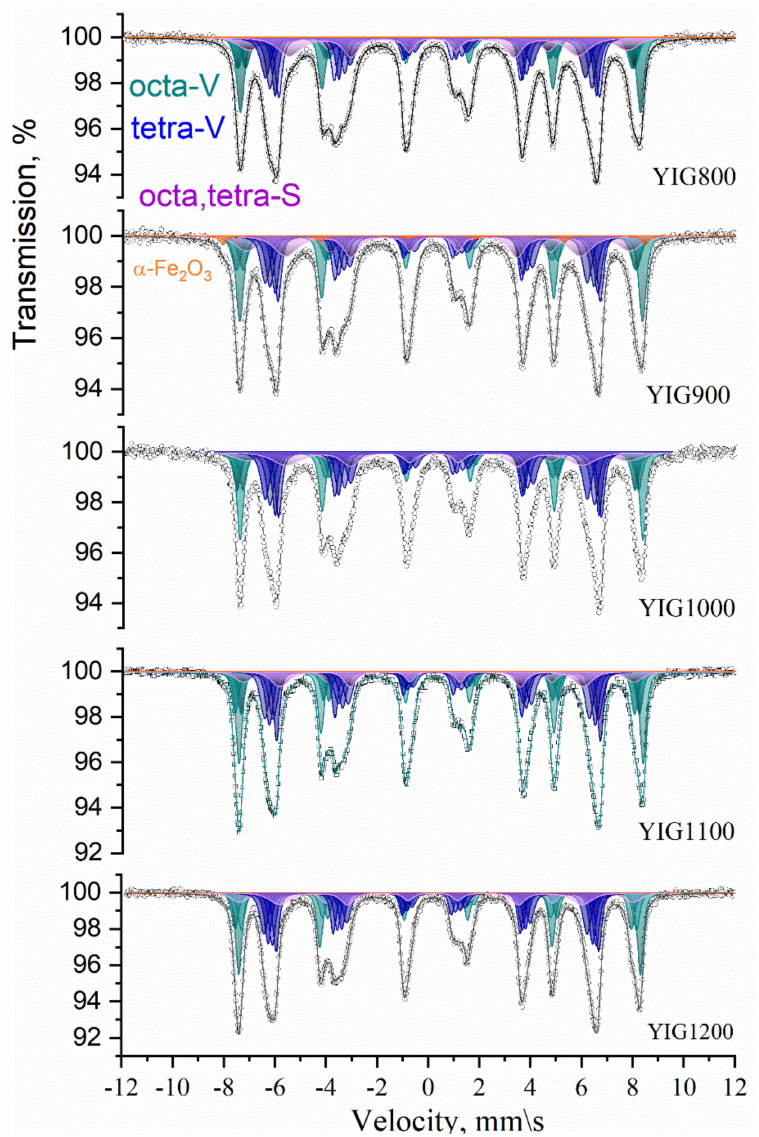
Figure 4. Mössbauer spectra of YIG particles measured at 300 K (octa-green and tetra-blue). Garnet phase model fitting was carried out because its ferrimagnetism is generally explained by the existence of two nonequivalent magnetic sublattices composed of iron atoms in (16) octahedral and (24) tetrahedral sites coupled antiferromagnetically. The Mössbauer spectrum of single crystal YIG usually consists of subspectra corresponding to several octahedral ( a ) (green colored) and tetrahedral ( d ) (blue colored) structural sites of Fe 3+ in oxygen surroundings [22], which amounts and parameters are determined by site population, angles θ between electric field gradient tensor principal axis, and the easy magnetization axis. We assume that synthesis resulted in the formation of the garnet phase subspectra components, their parameters, and mutual relation. The distortions [23] rotate the principal axis of the electric field gradient tensor relative to the [111] direction resulting